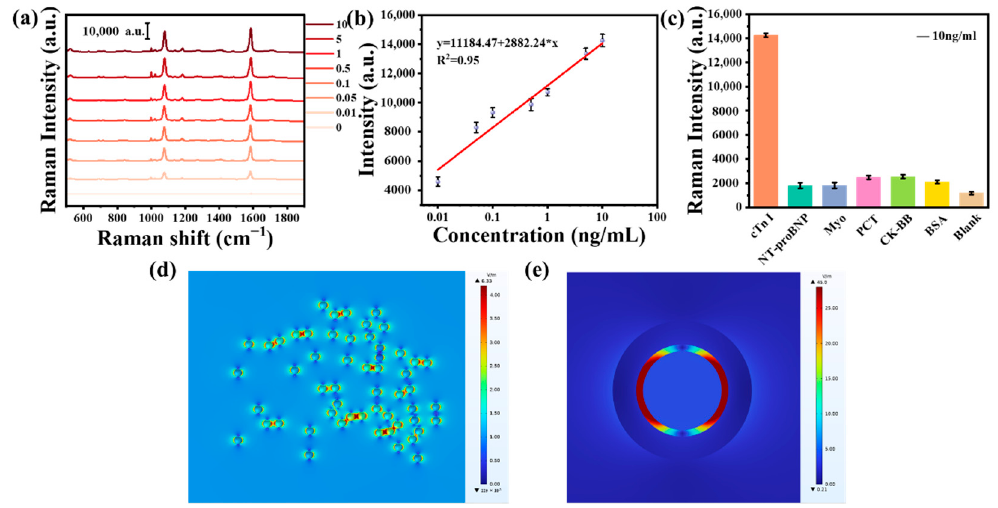
Figure 5. ( a ) Raman spectra of cTn I antigen samples with different concentrations on SERS nanotags; ( b ) linear relationship between Raman signal and cTn I antigen concentration; ( c ) Raman signals of different biomarkers to the SERS nanotags; ( d ) electrical field distributions of randomly distributed Au NSs; and ( e ) A u @Ag (633 nm laser wavelength).